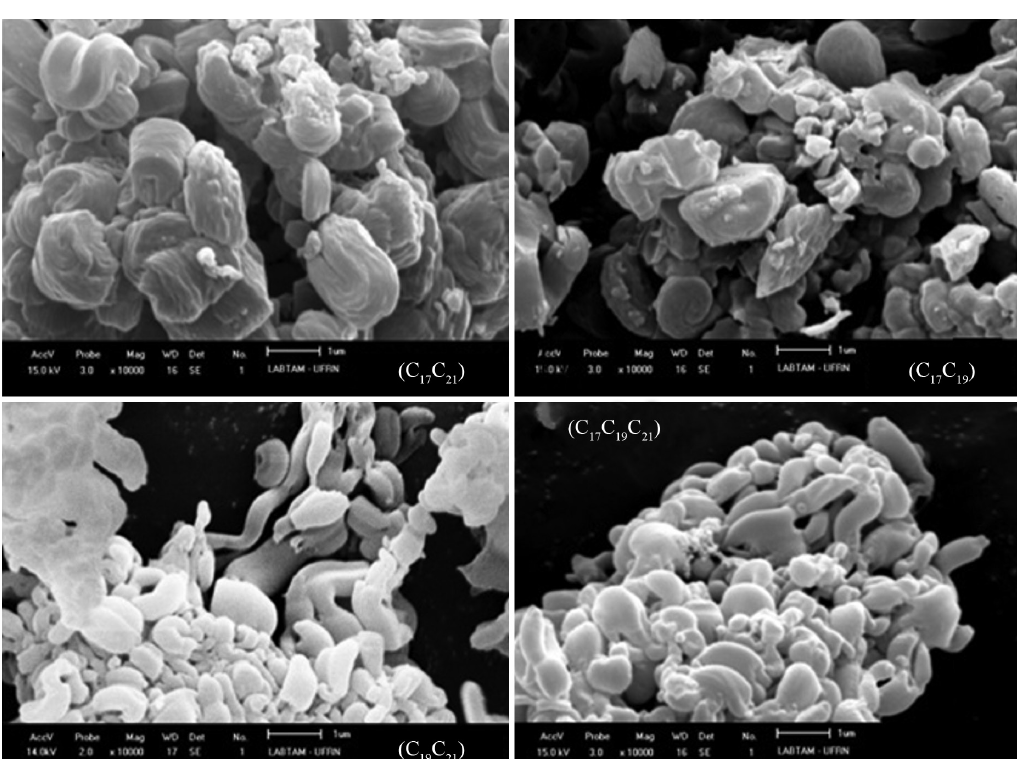
, (b) C and (c) C 17 19 21.